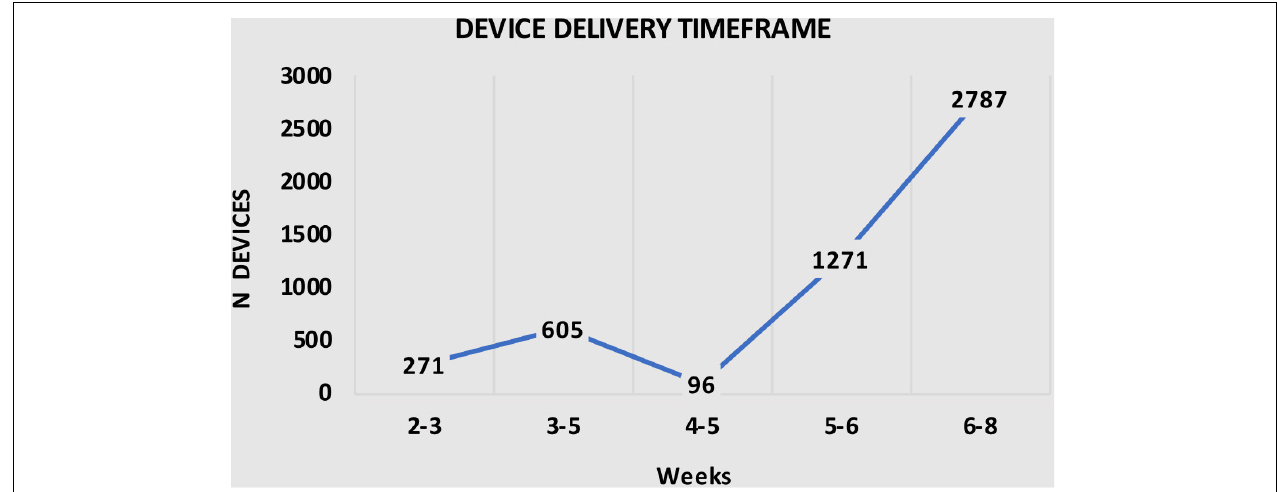
FIGURE 3 | Illustration of device according to delivery time frame.